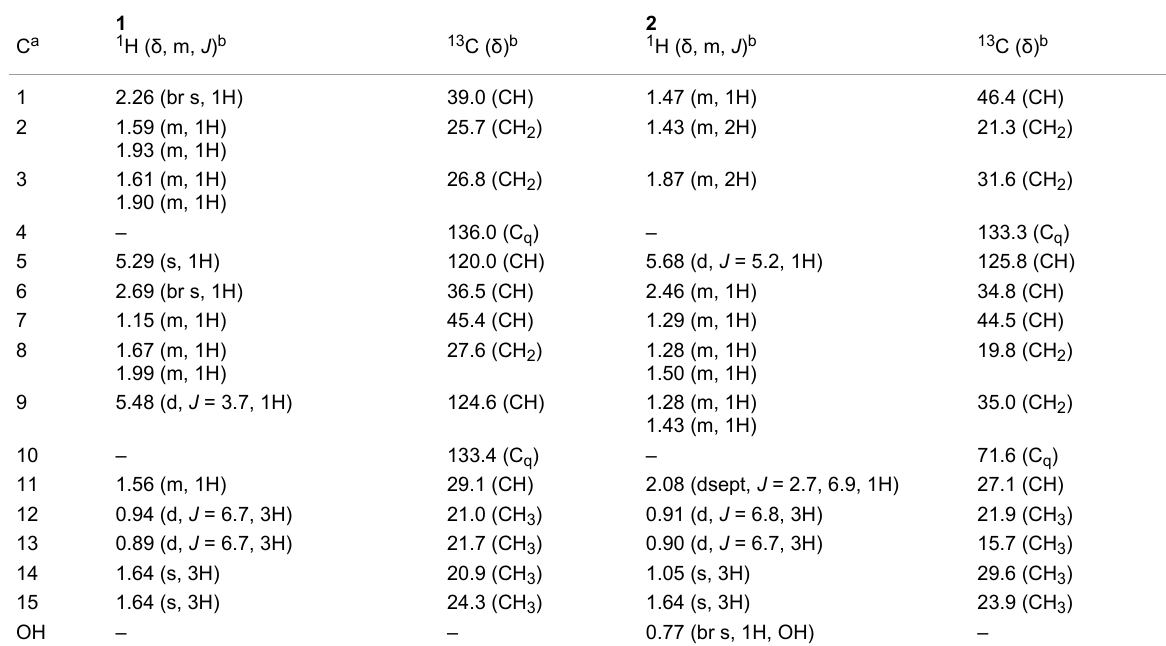
Table 1: NMR data of α -amorphene ( 1 ), and T-muurolol ( 2 ) in ( 2 H 6 )benzene.